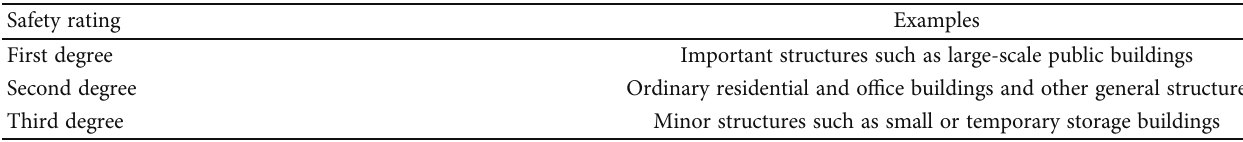
Table 5: Structural safety rating table.